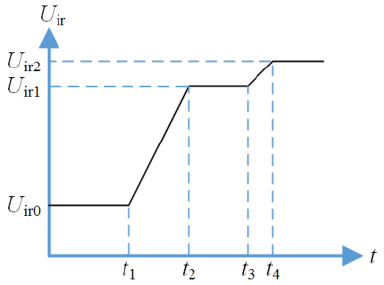
Figure 3. Changes of U ir in the improved impedance measurement scheme.